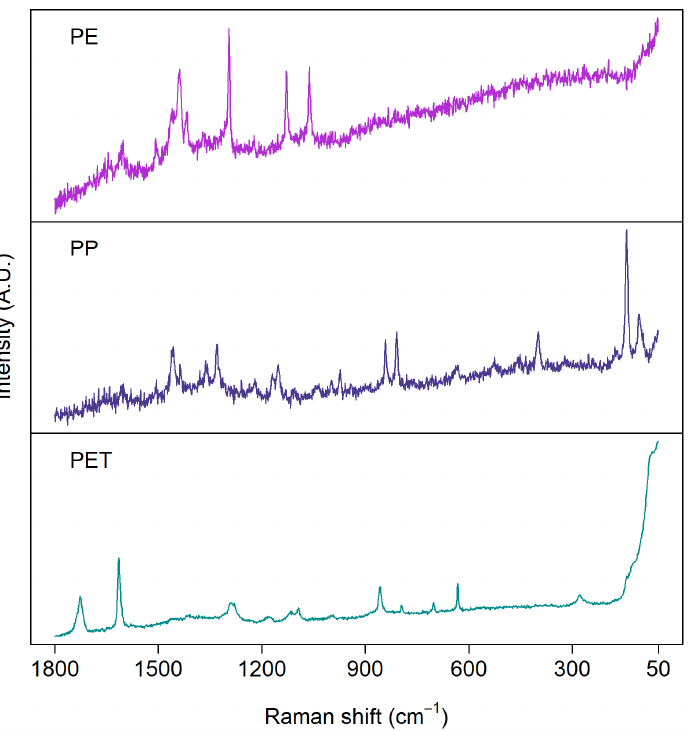
Figure 3. Examples of Raman spectra of microplastics measured from environmental samples: polyethylene (PE), polypropylene (PP), and polyethylene terephthalate (PET). Samples were measured with a 785 nm laser from aluminum oxide (Anodisc) filters.